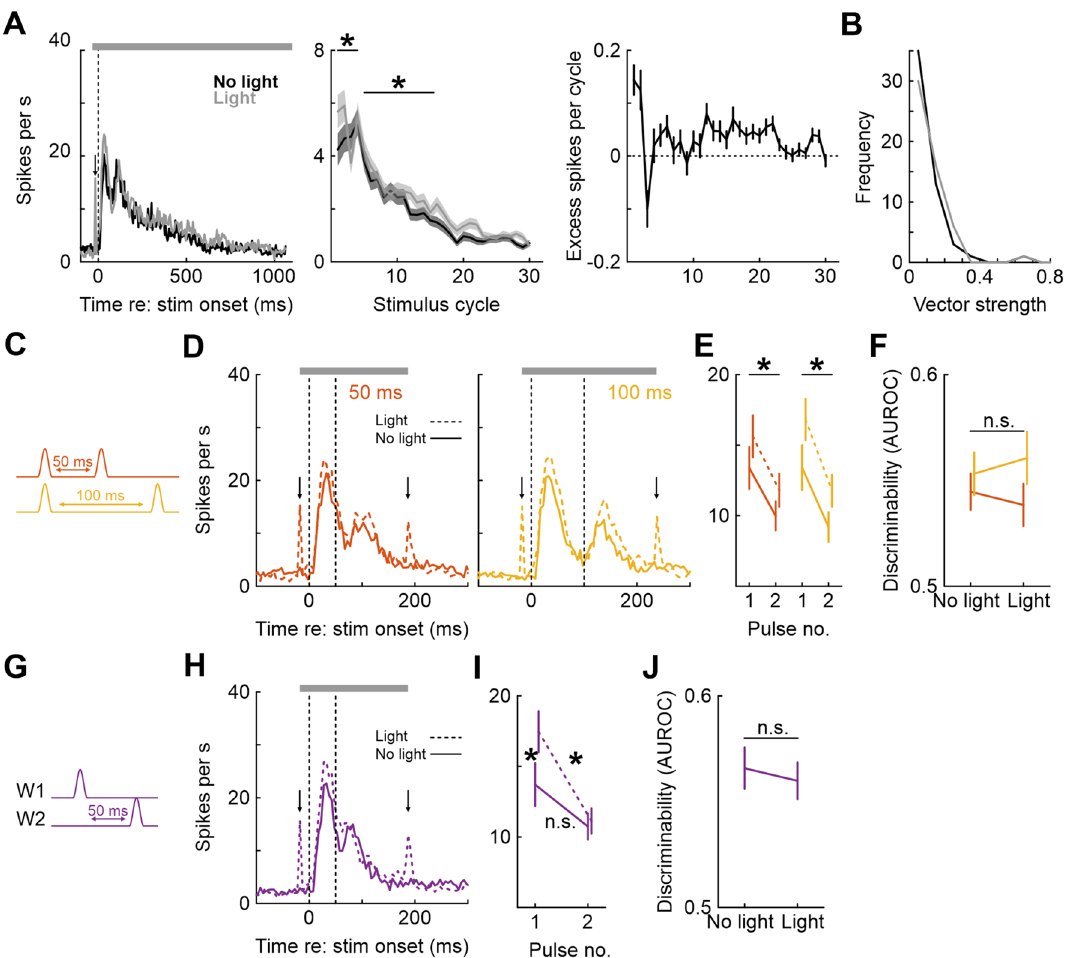
Figure 5. Effect of optogenetic inhibition of PV+ interneurons on vibrotactile and multiple whisker stimulation in single neurons. ( A ) Left: Mean PSTH across all units in response to a 1 s 30 Hz cosinusoidal vibrotactile stimulus, with and without light. Middle: Mean firing rate per stimulus cycle, shading represents SEM. Right: Number of additional (excess) spikes fired during light application (i.e., the difference between firing rates under light application and without light). Error bars represent SEM. ( B ) Histograms of vector strengths for all units. ( C – F ) Effect of PV inhibition during single-whisker double-pulse stimulation on neuronal activity. ( C ) Illustration of the stimulus protocol. ( D ) Left: Mean PSTHs in response to stimulation, with (dashed lines) and without (solid lines) light application for 50 ms interpulse intervals. Vertical dashed lines denote deflection onsets. Right: Same, but for 100 ms interpulse intervals. ( E ) Mean firing rates (and SEM) during the first and second stimulus pulses, for 50 and 100 ms interpulse intervals, with and without light application. ( F ) Neurometric discriminability (AUROC) of 50 and 100 ms double pulse stimulus compared to single W1 deflections. ( G – J ) Effect of PV inhibition during two-whisker consecutive stimulation. ( G ) Illustration of stimulus protocol. ( H ) Mean PSTH in response to W1- > W2 stimulation (50 ms interpulse interval), with and without light. Conventions as in D. ( I ) Mean firing rate in response to each of the two deflections, with and without light. ( J ) Neurometric discriminability (AUROC) for the double-pulse stimulus compared to a single W1 deflection, averaged over all